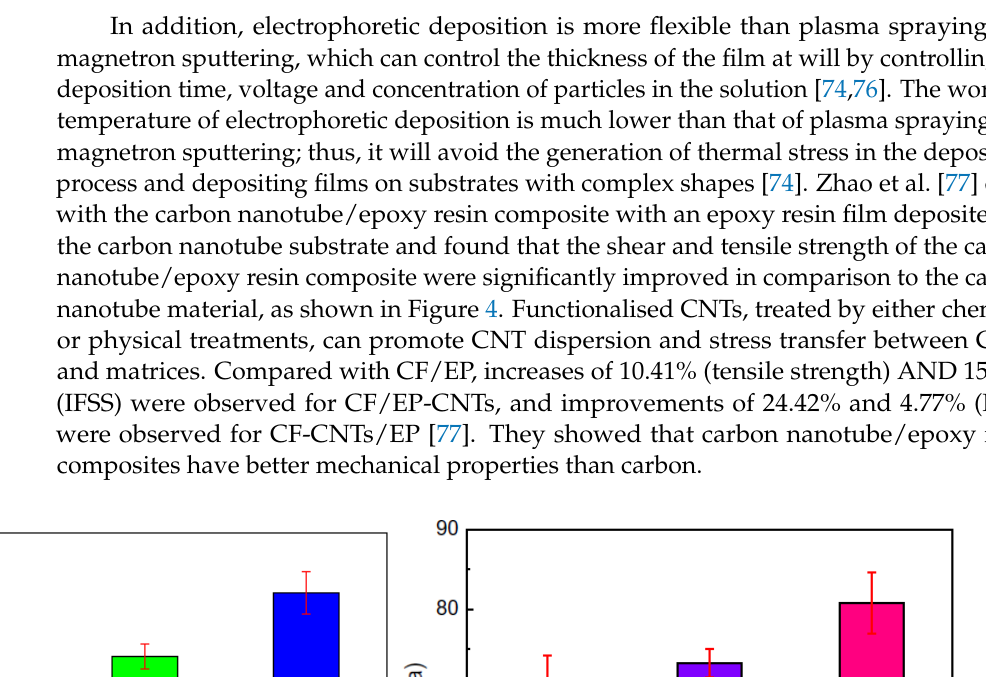
Figure 3. Electrophoretic deposition. ( a ) Cathodic EPD and ( b ) anodic EPD [74].